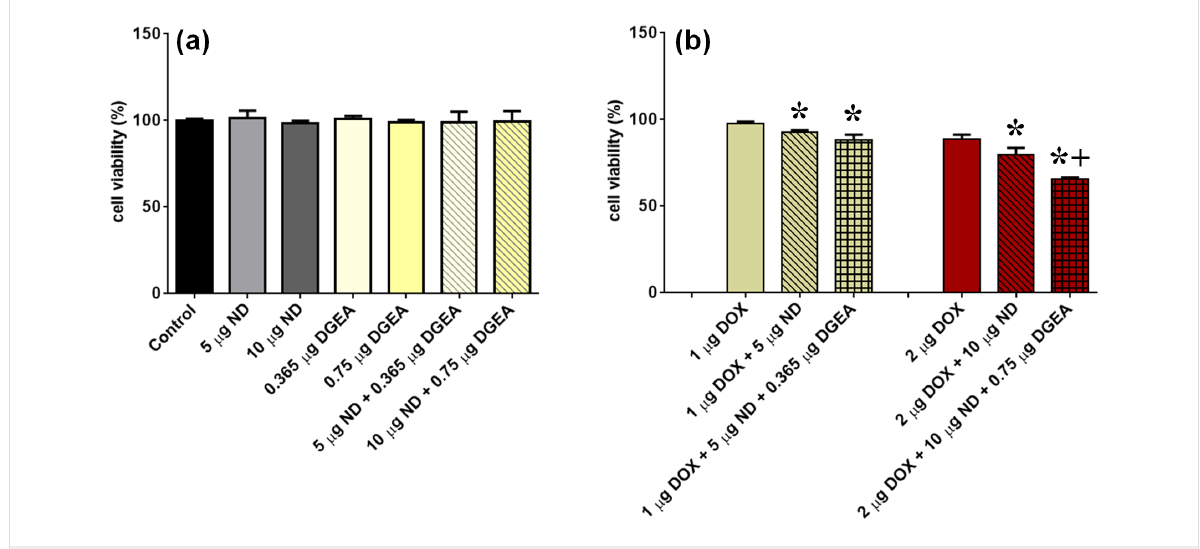
Figure 6: MTS assay of cell viability after 32 h exposure to various treatments. PC3 cells were treated with concentrations per mL of (a) ND, ND-DGEA, and DGEA peptide and (b) DOX, ND-DOX, and ND-DGEA-DOX. Symbols indicate significant difference (p < 0.05) when compared to drug alone ( * ) and ND-DOX system ( + ) at same